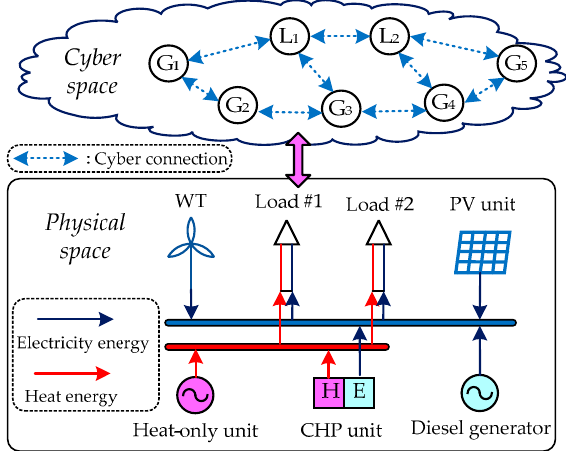
Figure 1. Framework of distributed heat-electricity energy management (HEEM) in an islanded microgrid.